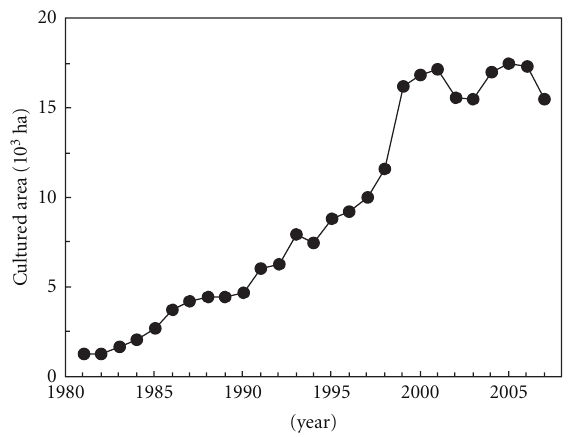
Figure 4: Historical changes in areas of aquaculture of bivalves in Jiaozhou